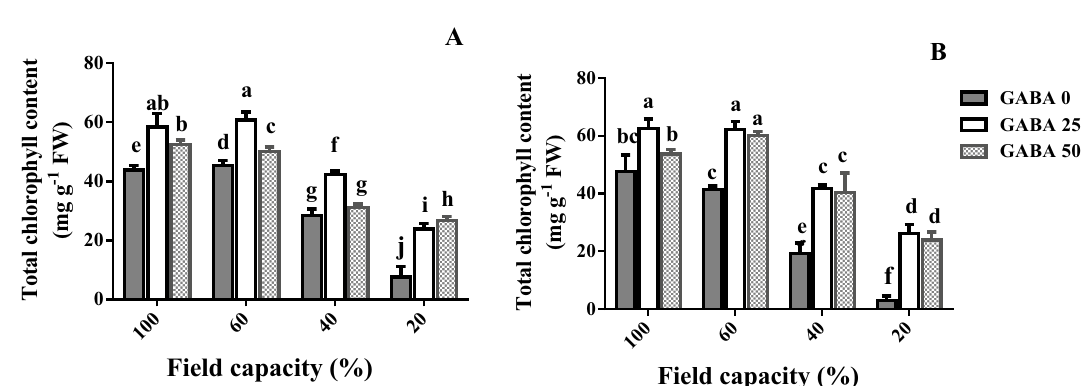
Figure 3. Leaf chlorophyll content of cv. Arman cultivar (tolerant; A ) and cv. Azad cultivar (sensitive; B ) chickpea plants receiving exogenous application of γ-aminobutyric acid (GABA) at different concentrations (0, 25 and 50 μM) under different watering levels (100, 60, 40 and 20% field capacity) during cultivation. Within each insert, different letters indicate significant differences. Error bars indicate SEM (n = 3). FW fresh